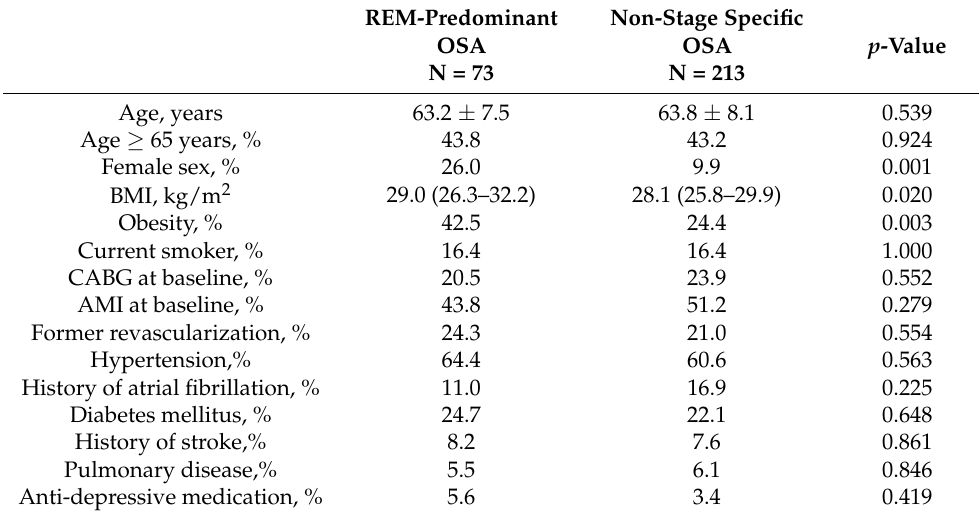
Table 1. Baseline demographic and clinical characteristics of the study population ( n = 286).